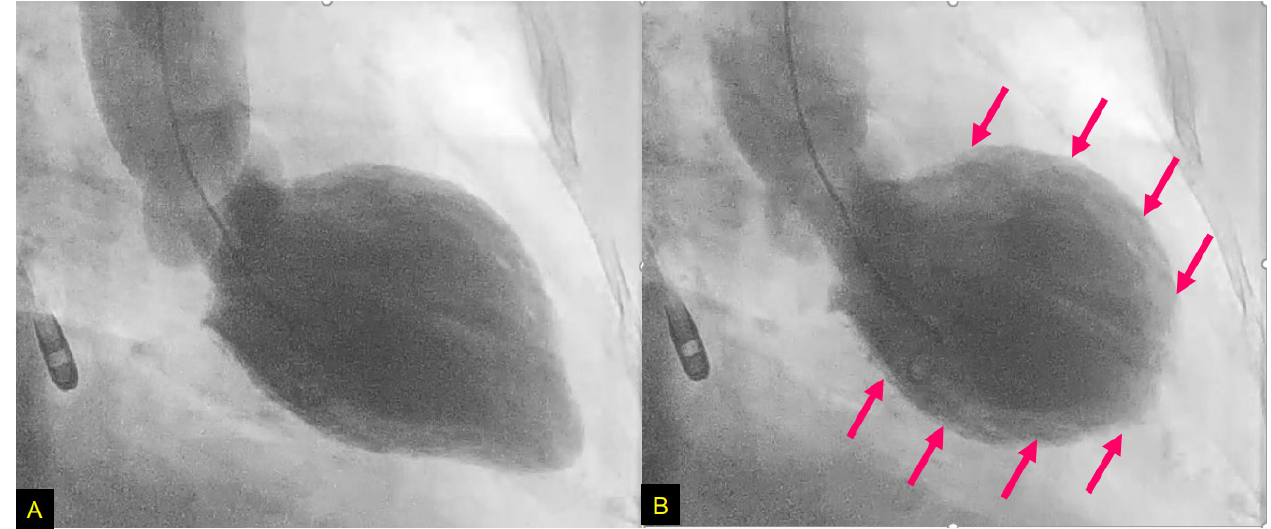
Figure 8. Left ventriculography. End-diastolic-phase left ventriculogram ( A ) and end-systolic-phase left ventriculogram ( B ). The extensive area around the mid-portion shows akinesis (arrows), and the basal and apex portions display hypercontraction, especially in the end-systolic phase ( B ). From [96].